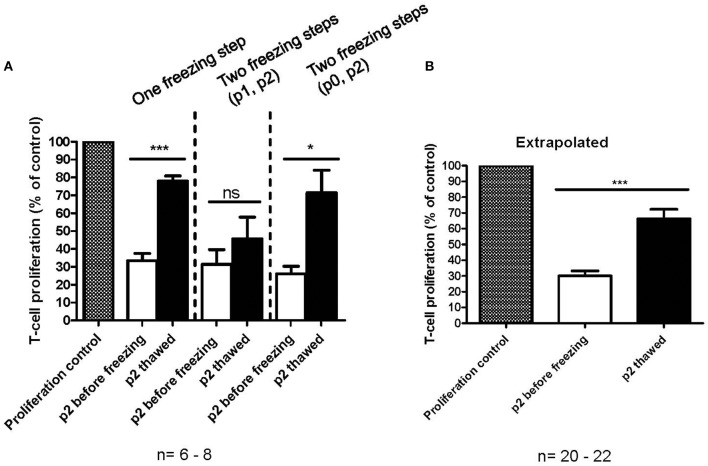
In vitro immunosuppression capacity of cryopreserved MSCs as measured by a T-cell proliferation assay. (A) Immunosuppression capacity of MSCs before (white) and after freezing and thawing (black) with one freezing step at passage 2 (p2) or two freezing steps at either p0 or p1 and p2. The results are presented as mean ± SEM (n = 6-8). (B) Comparison of fresh (white) and frozen and thawed (black) MSCs in p2. The data in extrapolated from all the data presented in (A), regardless of the number of freezing steps. The results are presented as mean ± SEM (n = 20–22). *p < 0.05, ***p < 0.001.